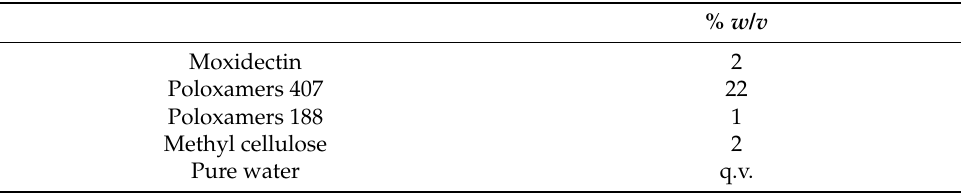
Table 4. The composition of the MXD-TG